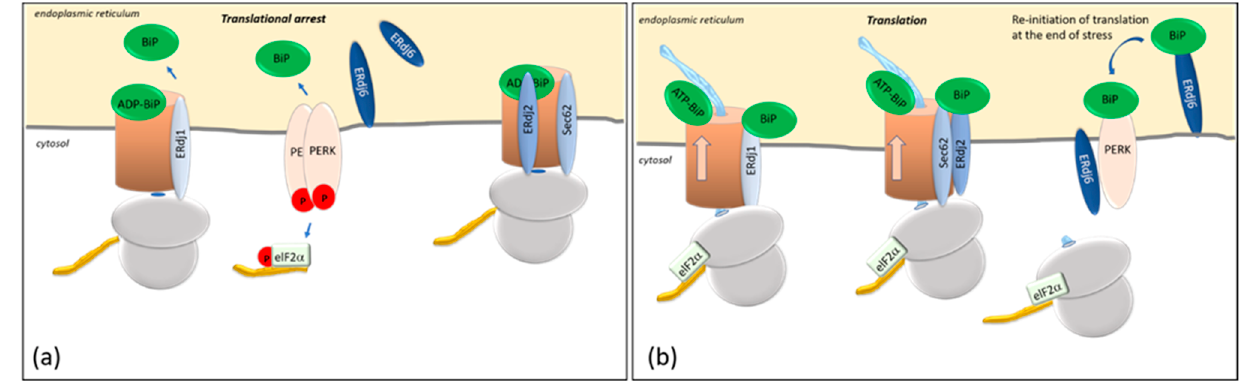
Figure 1. ( a ) At the translocon (brown cylinder), the pore is gated by BiP, which, in its ADP-bound form, closes the gate and opens it in its ATP-bound form. Translational arrest occurs when BiP dissociates from the luminal domains of ERdj1, ERdj2, and PERK. The release of BiP from PERK results in the dimerization of PERK, its autophosphorylation, and the subsequent phosphorylation of eIF2 α (p-eIF2 α ), which inhibits eIF2 α -dependent translation. ( b ) The translation of proteins is controlled by the co-chaperones ERdj1, ERdj2/Sec62, and ERdj6. In their BiP-bound forms, ERdj1 and ERdj2/Sec62 enable protein synthesis. The silencing of PERK and the PERK-signaling pathway occur by the binding of BiP to its luminal domain, which results in the release of eIF2 α -dependent translation and protein synthesis. BiP, immunoglobin binding protein; PERK, protein kinase RNA-like endoplasmic reticulum kinase; eIF2 α , alpha subunit of eukaryotic initiation factor 2.